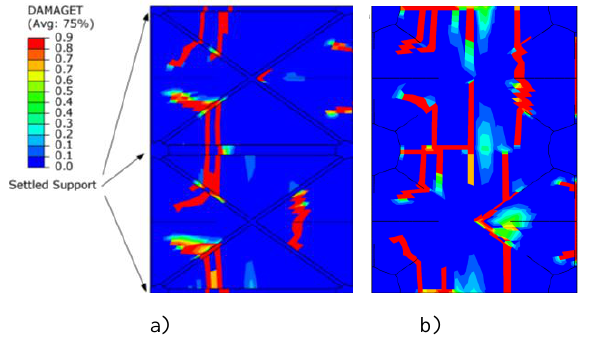
Figure 14. Damage simulation due to vertical support settlement: a) intrados view, b) extrados view